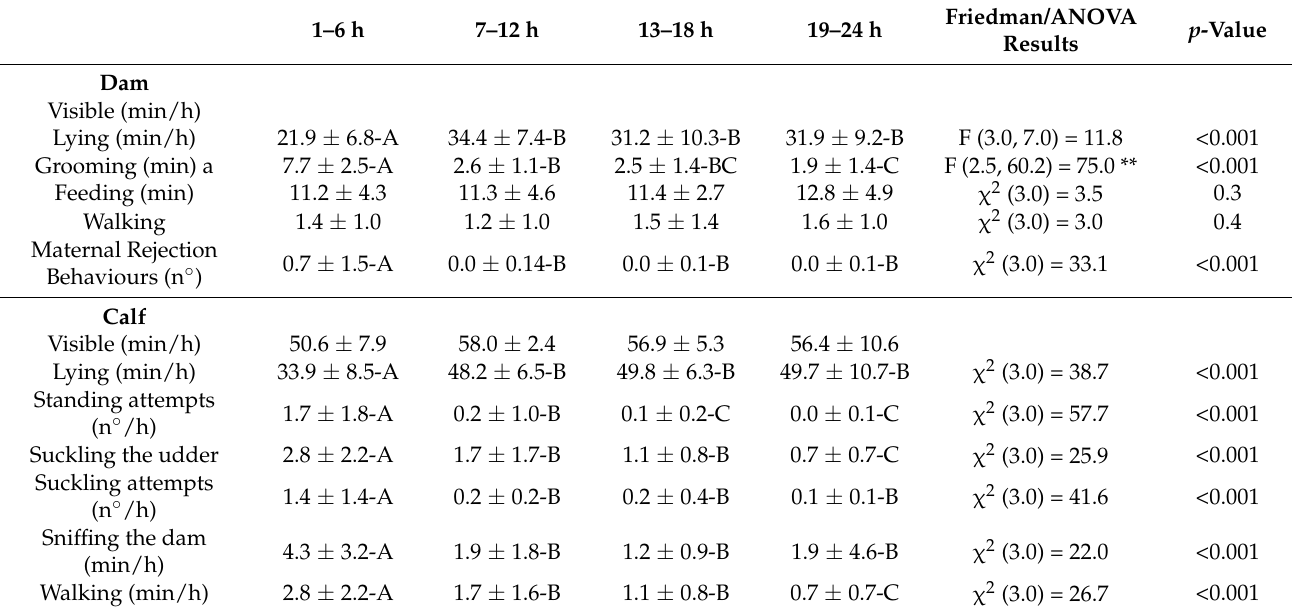
Table 4. Behaviours during the six-hour time